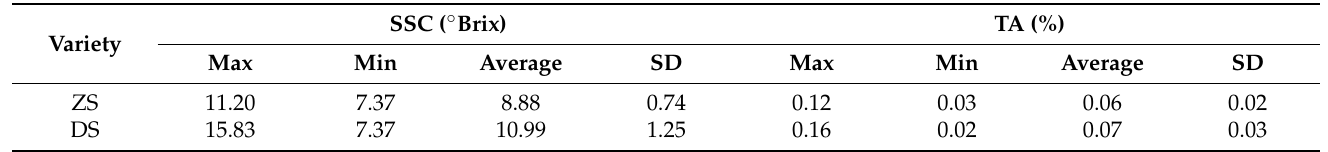
Table 1. Soluble solid content (SSC) and titratable acidity (TA) of ‘Zaosu’ and ‘Dangshansuli’ pear cultivars. SSC ( ◦ Variety